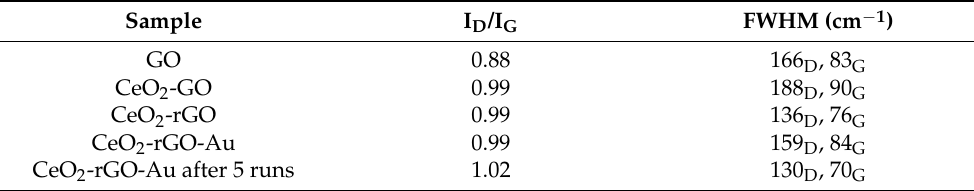
Table 1. Raman parameters related to the D and G bands.